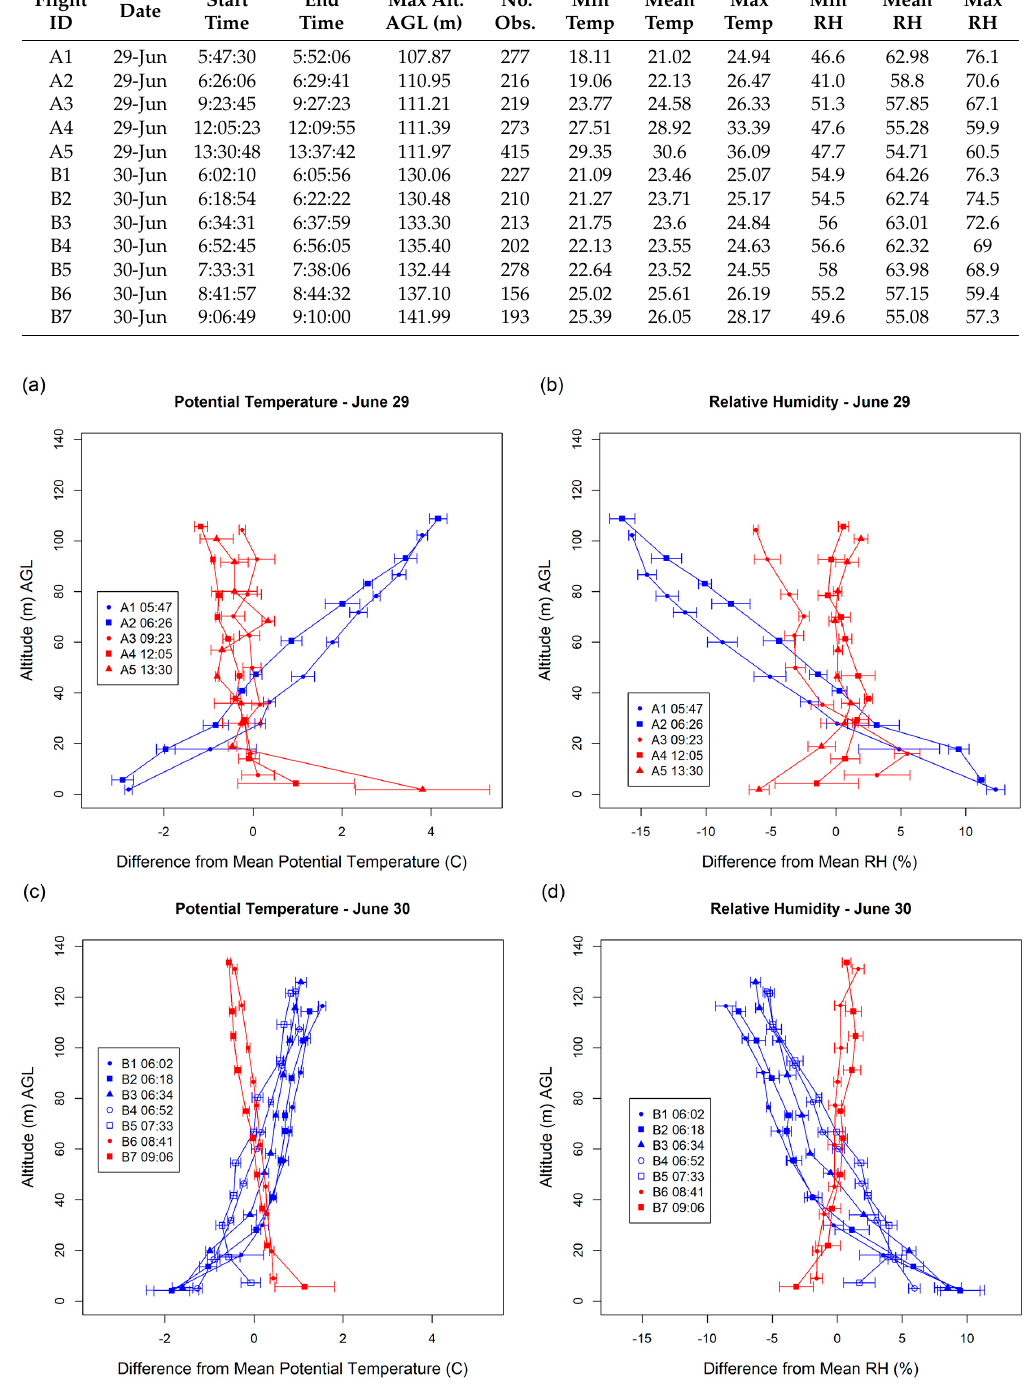
Figure 4. Profile plots for ( a ) June 29 potential temperature, ( b ) June 29 relative humidity, ( c ) June 30 potential temperature, and ( d ) June 30 relative humidity. Flight start times are in Central Daylight Time (UTC-5).